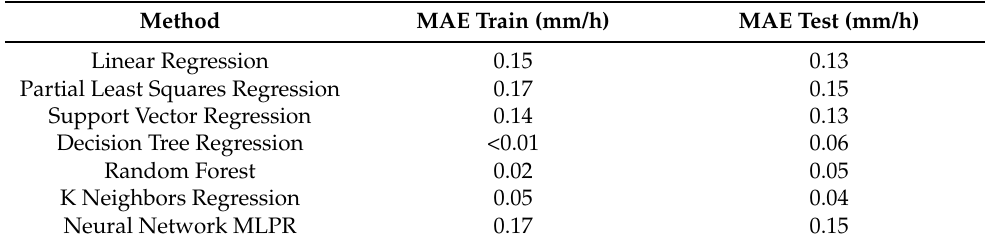
Table 1. Comparison between different machine-learning methods applied to the dataset (April 2019). MAE train and test are the Mean Absolute Errors obtained for the training and test dataset,